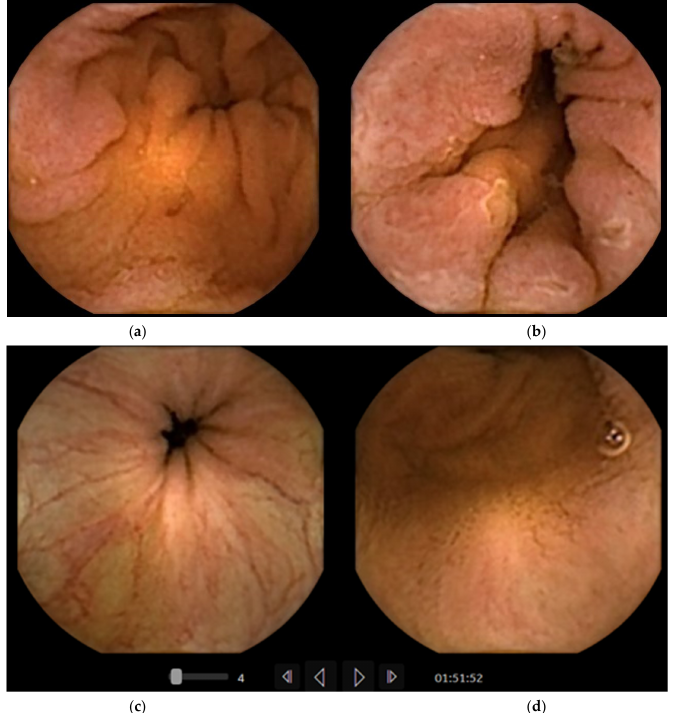
Figure 3. Perfect mucosa visualization in the terminal ileum after lavage and booster. ( a , b ) Pan-intestinal capsule PillCam Crohn’s, b with aphthous ulcer; ( c , d ) normal terminal ileum in colon capsule PillCam Colon2. Adler and coworkers found a better visualization of distal SB mucosa with Picolax (NaP and citrate) 1 h after ingesting the capsule compared with PEG the evening before SBCE [38]. A recent prospective trial compared 1 L of Moviprep after the capsule had entered the small bowel with Moviprep the day before. Good or excellent visualization was documented by two investigators in 79/76% compared with 45/42% after Moviprep in the evening ( p < 0.005). The diagnostic yield for angiectasias, the most frequent finding, was also higher, with 27% vs. 10%, respectively ( p = 0.022) [28]. Both groups stayed on clear liquids the day before SBCE and fasted overnight. 4.2.5. Influence of Lavage on Small Bowel Transit Complete visualization of the entire small bowel is a prerequisite for correct diagnos- tics. The first generations of capsules with limited battery lifetime had a relevant percent- age of incomplete investigations. In a comparative study with two different capsules swal- lowed in parallel, all four patients in whom PillCam had missed a relevant lesion with